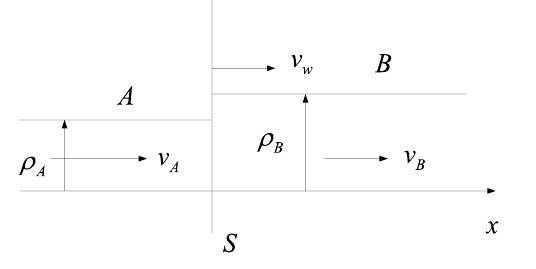
Fig. 1 Ship traffic flow status of two different densities